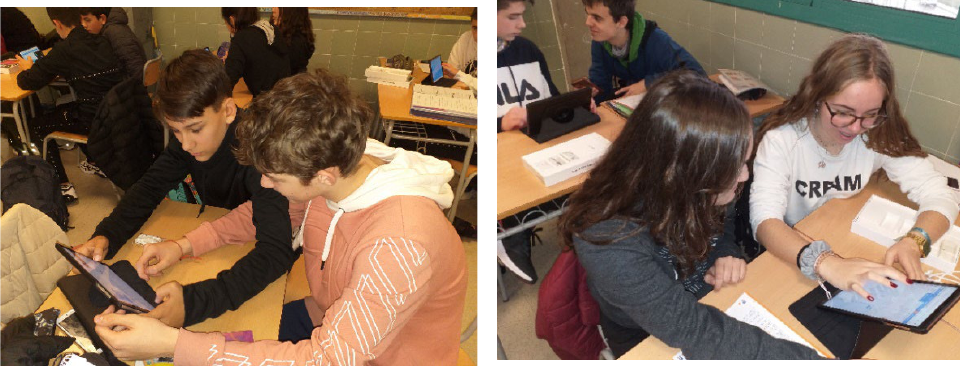
Figure 2. Students working in pairs with the math digital tools.